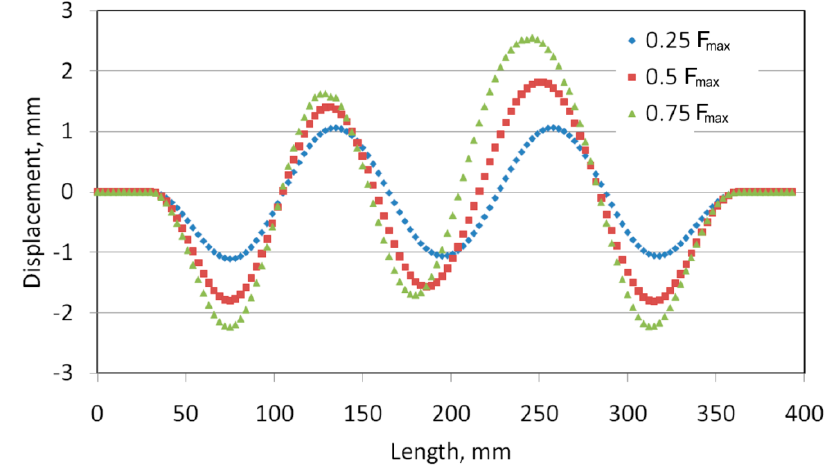
Figure 12. Out ‐ of ‐ plane deformation of the stiffened panel with welded stringers ( s = 44.25 mm). Figure 12. Out-of-plane deformation of the sti ff ened panel with welded stringers ( s = 44.25 mm).